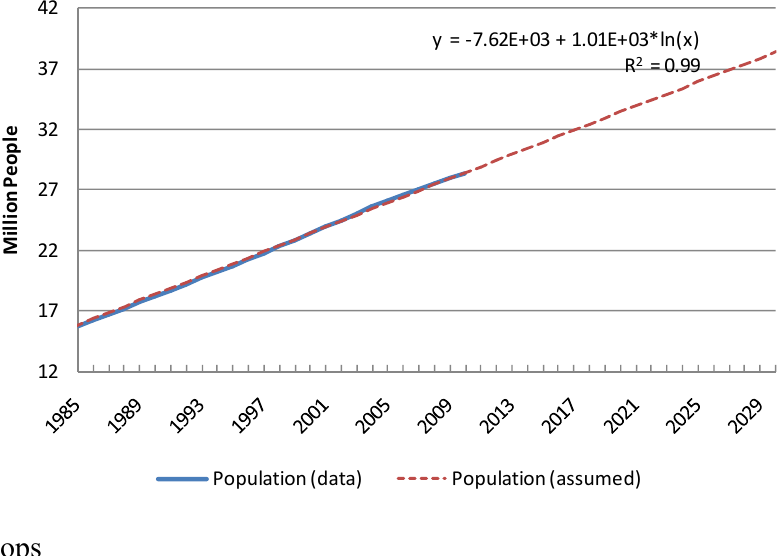
Figure 13. Malaysia’s population data (Source: [51]) and assumed